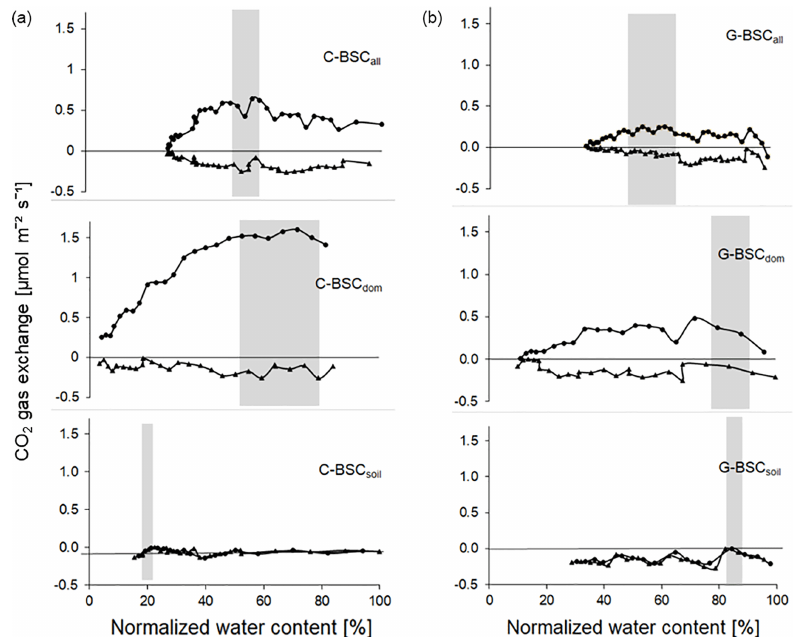
Figure 4. Responses of net photosynthesis (dots) and dark respiration (triangles) to normalized water content for intact BSC, the isolated dominant organisms and in soil at 12 ◦ C. Measurements were taken at saturating light and a temperature of 12 ◦ C. (a) C-BSC (985µmol pho-